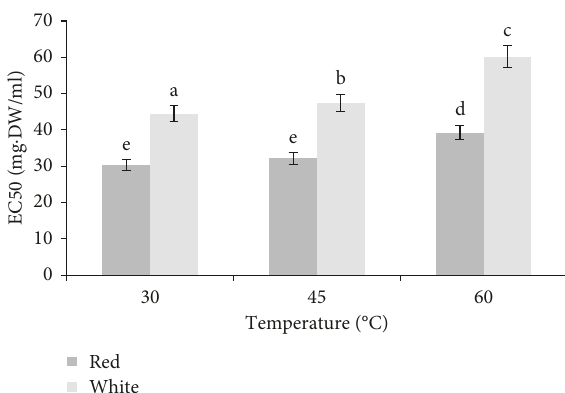
Figure 2: Comparison of reducing power of red and white quinoa sprouts extracts.